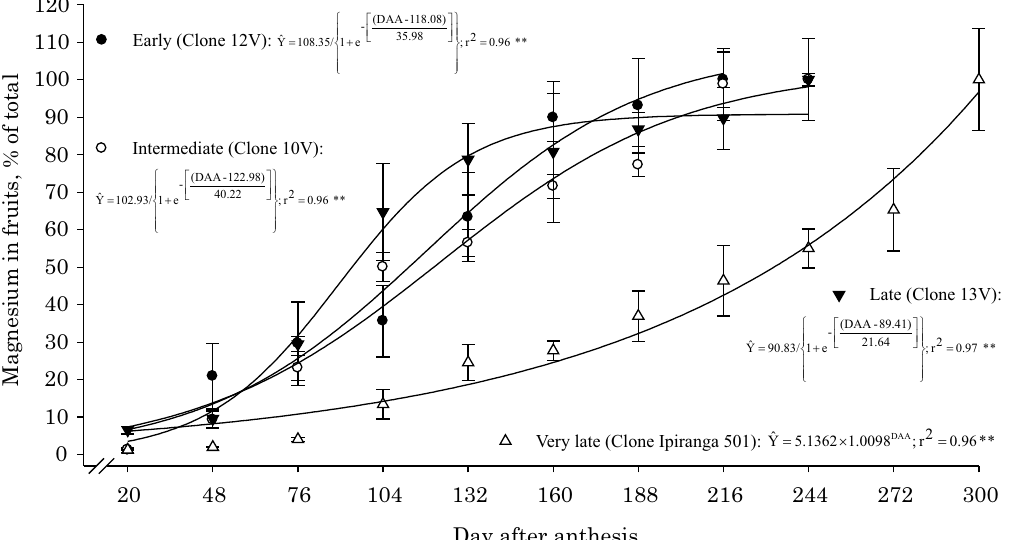
Figure 6. Accumulation of magnesium in fruits (in percentage of the cumulative total) of four genotypes (clones) of Conilon coffee, from anthesis to fruit maturation. The bars refer to the standard error of the average. ** significant at 1 % probability.